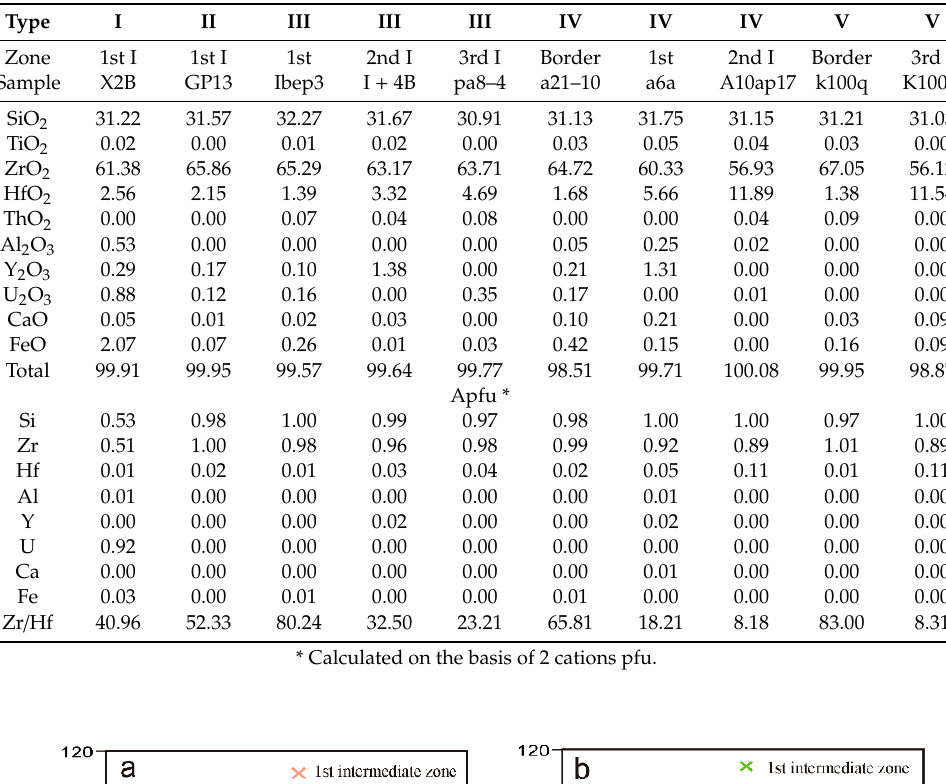
Table 1. Representative chemical composition (wt.%) of zircon from the Giraúl pegmatites.